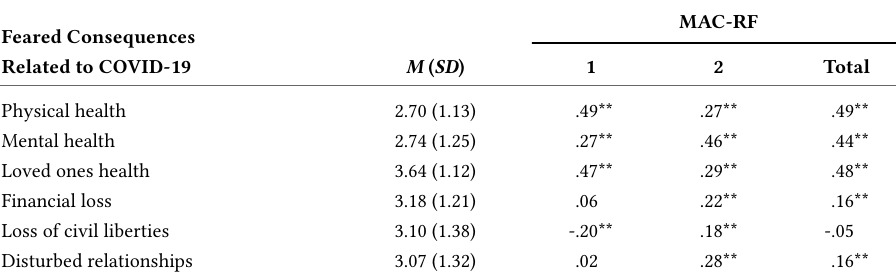
Disturbed relationships